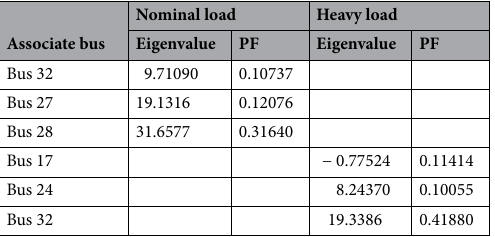
Table 2. Eigenvalue of weakest buses. The results confirmed that bus 32 is the weakest bus of the system because it has the lowest eigenvalue of 9.71.